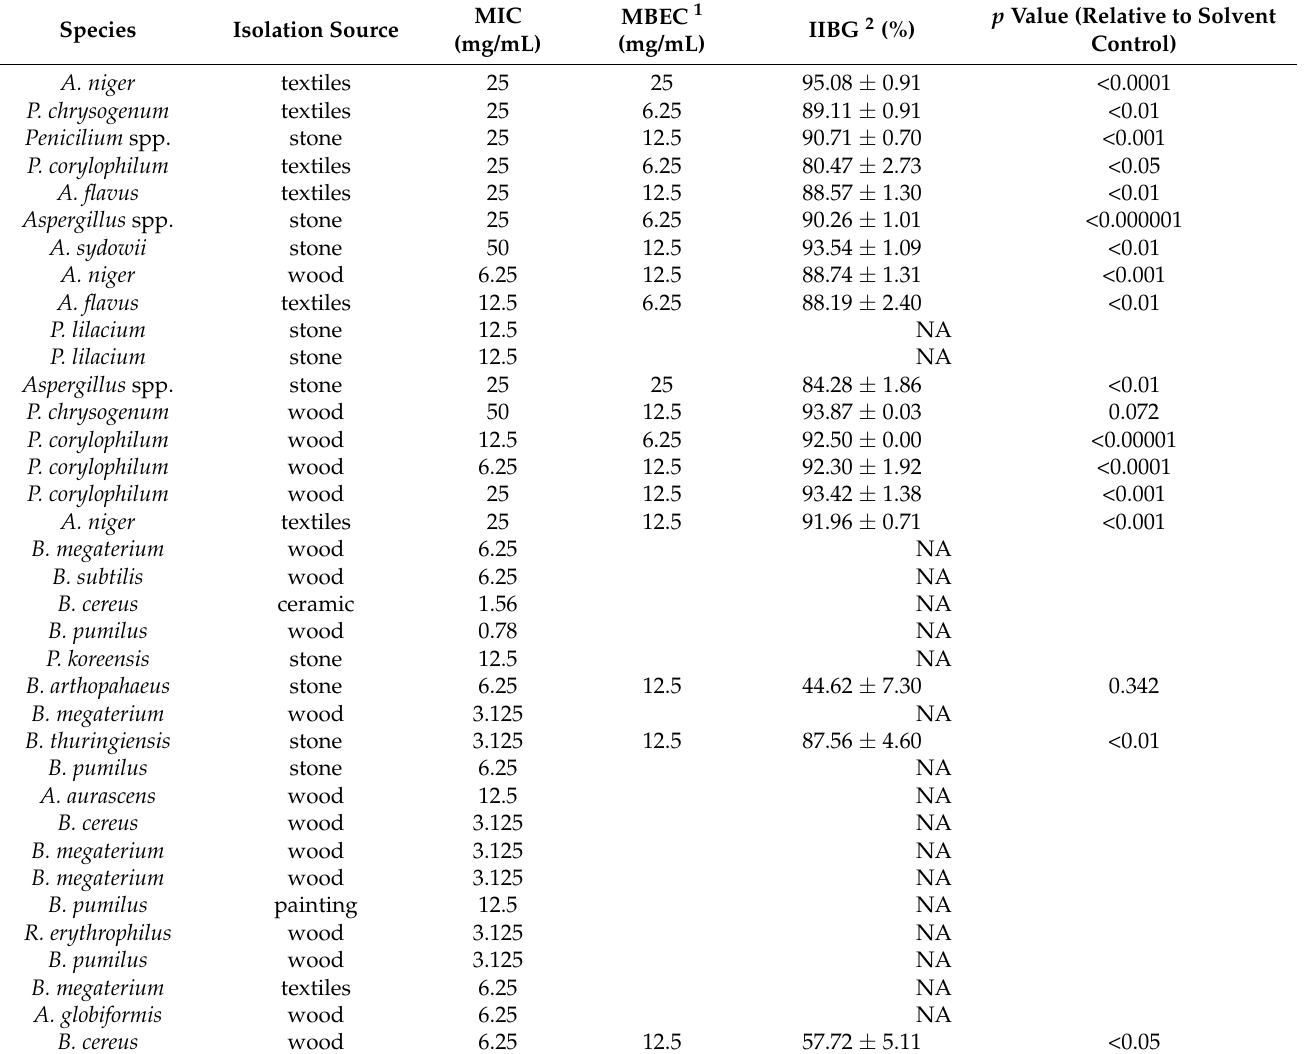
Table 3. The MIC and MBEC values of the A. sativum hydro-alcoholic extract.